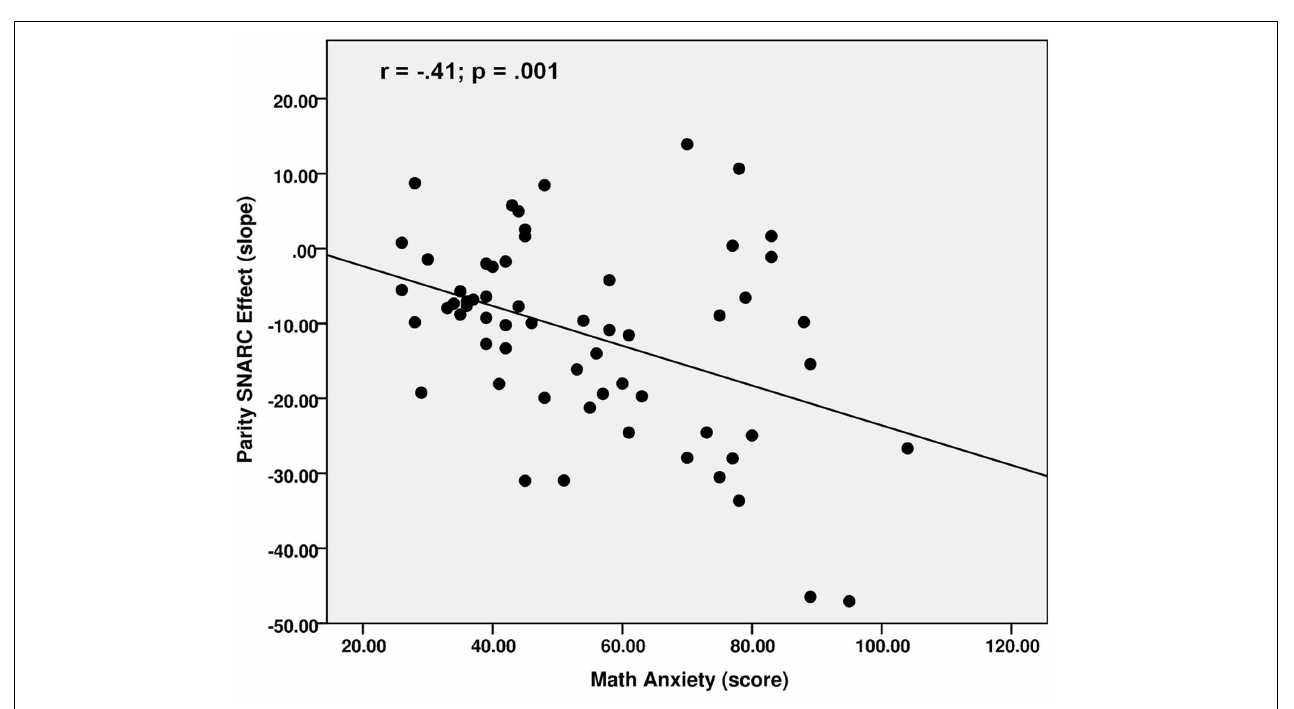
FIGURE 2 | Correlation between math anxiety scores and the parity SNARC effect regression